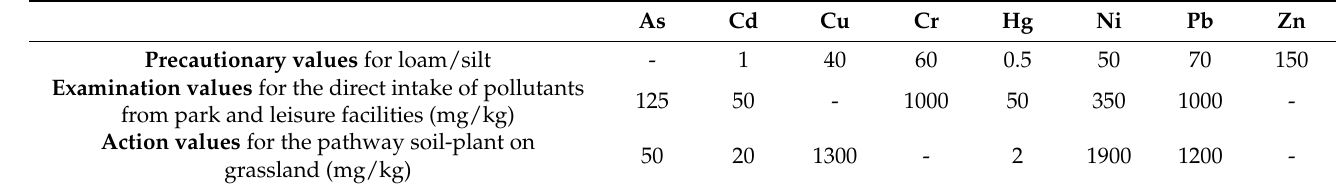
Table 9. Legal guideline values according to Annex 2 of the Federal Soil Protection Ordinance [19]. As Cd Cu Cr Hg Ni